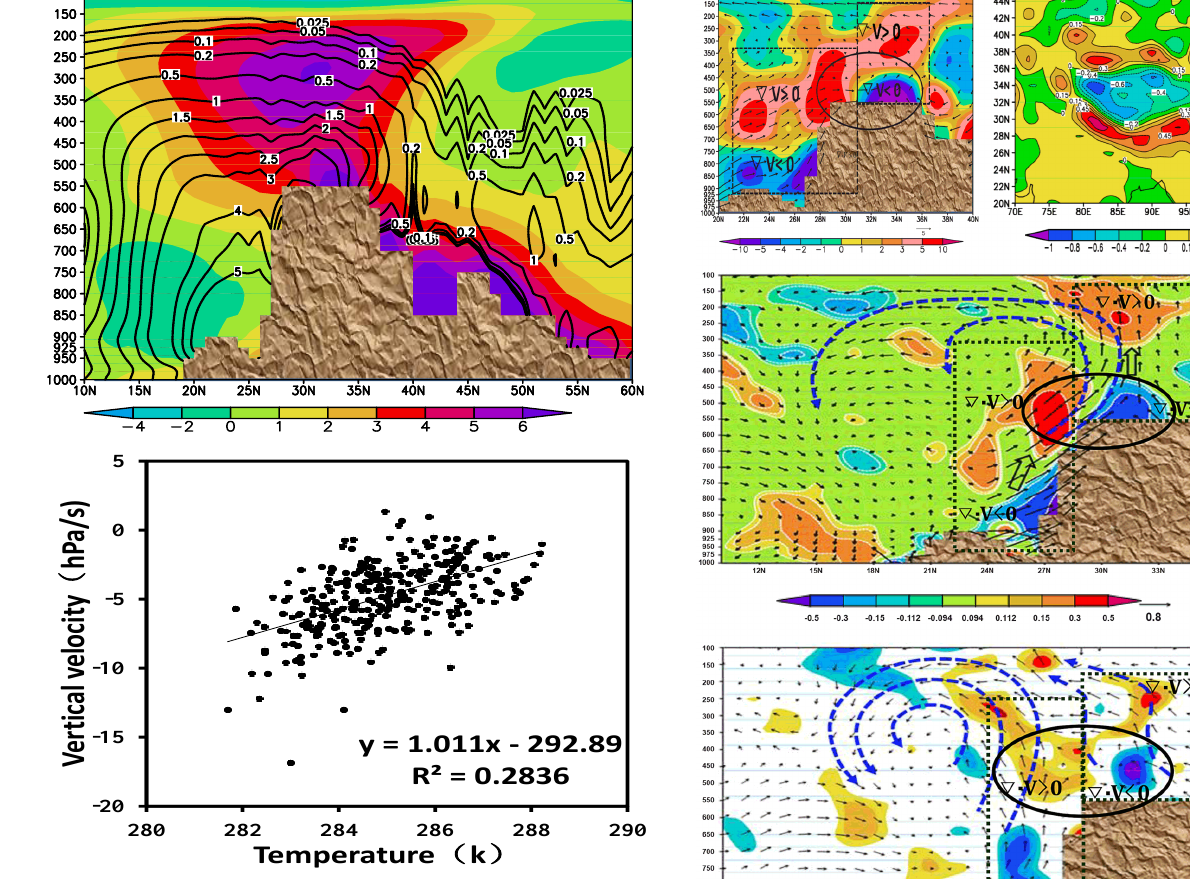
Figure 2. Vertical sections of air temperature ( ◦ C; filled contours) and specific humidity (gkg − 1 ; contour lines) differences relative to the zonal means along 93–94 ◦ E in summer averaged over 2000– 2009. The plateau section is marked with soil color (upper panel). A scatter plot of surface air temperature and vertical velocity at 500hPa in the TP region in July 2000–2009 (lower panel). Figure 3. Vertical sections of wind vectors and divergences (filled